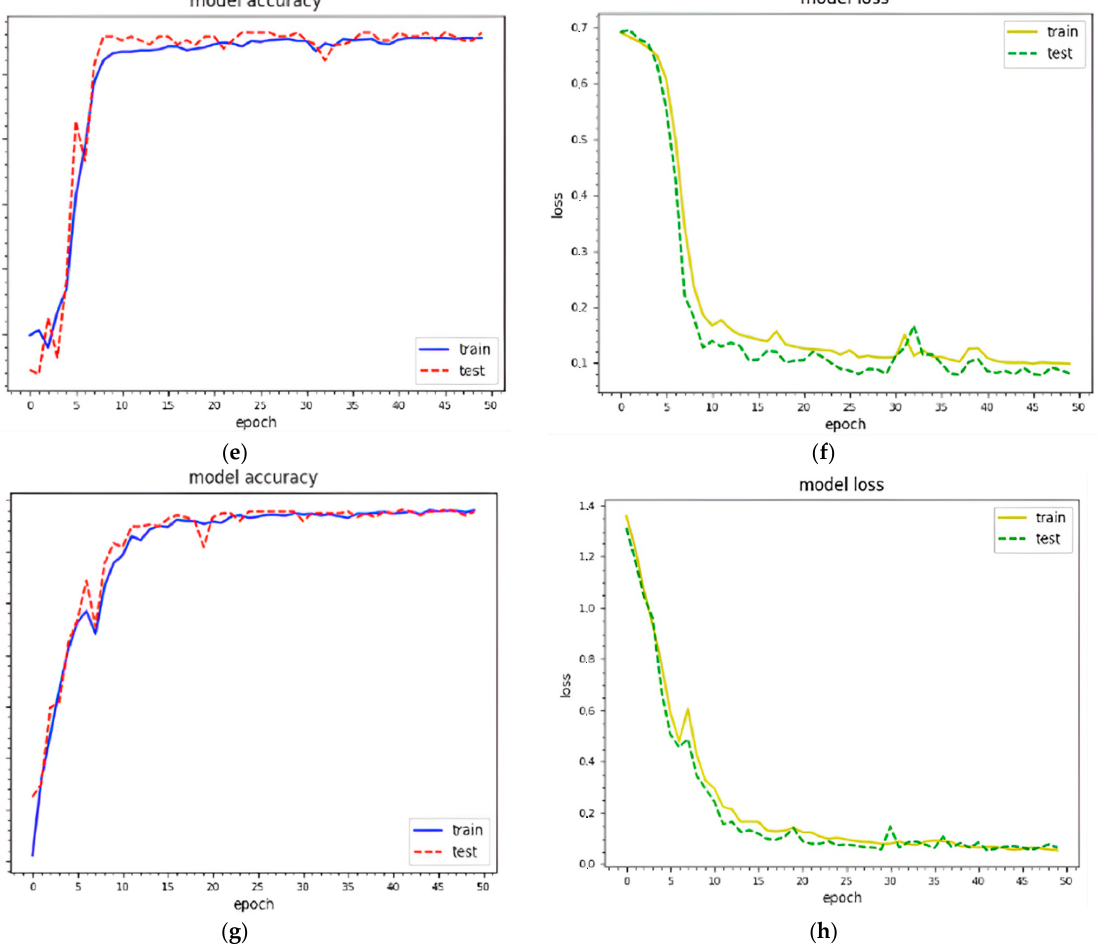
Figure 6. Epoch curves for training and testing data points using different visual representations for dataset 2 , i.e., 229 × 229, 256 × 256. (training accuracy, training loss; testing accuracy, testing loss). ( a ) 229 × 229 (classification); ( b ) 229 × 229 (classification); ( c ) 229 × 229 (detection); ( d ) 229 × 229 (detection); ( e ) 256 × 256 (classification); ( f ) 256 × 56 (classification); ( g ) 256 × 256 (detection); ( h ) 256 × 256 (detection).